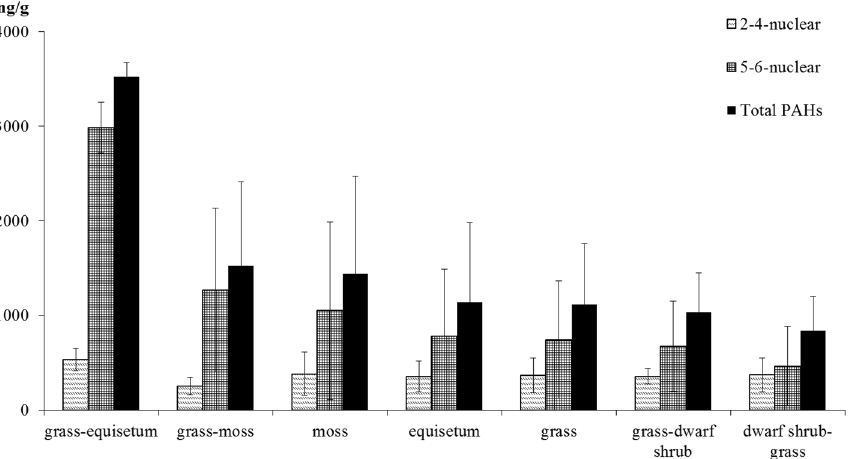
Figure 6. Distribution of low-molecular-weight (light) and high-molecular-weight (heavy) PAHs in peats of various plant macrofossils.